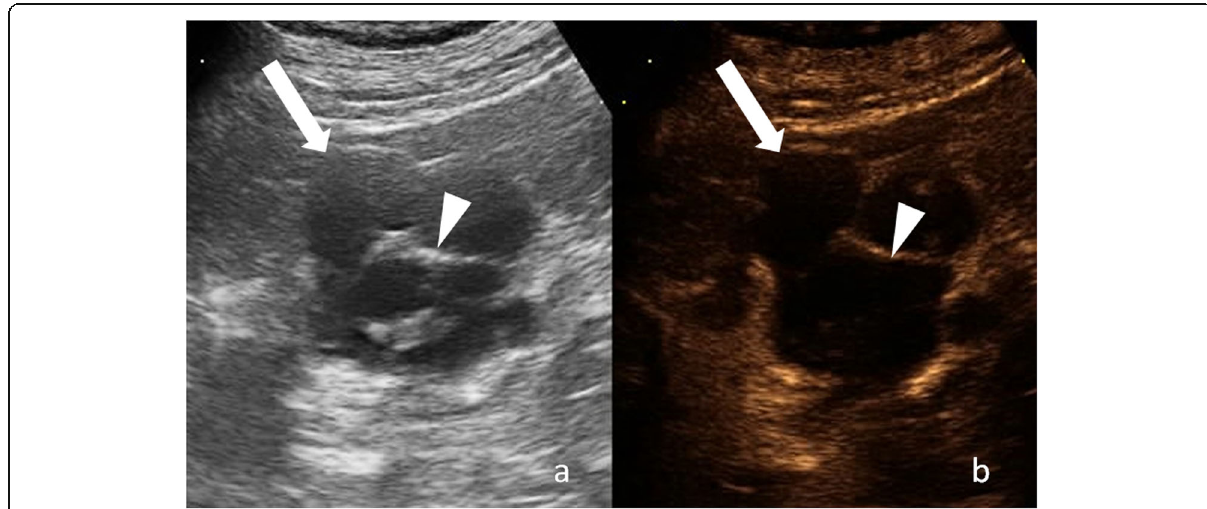
Fig. 1 Cystic renal lesion in a 76-year-old-man. a Gray-scale ultrasound shows a cystic lesion (arrow) with a thin wall and thin septa (arrowhead), which contains fine calcifications. b Corresponding CEUS image shows enhancement of cyst wall and